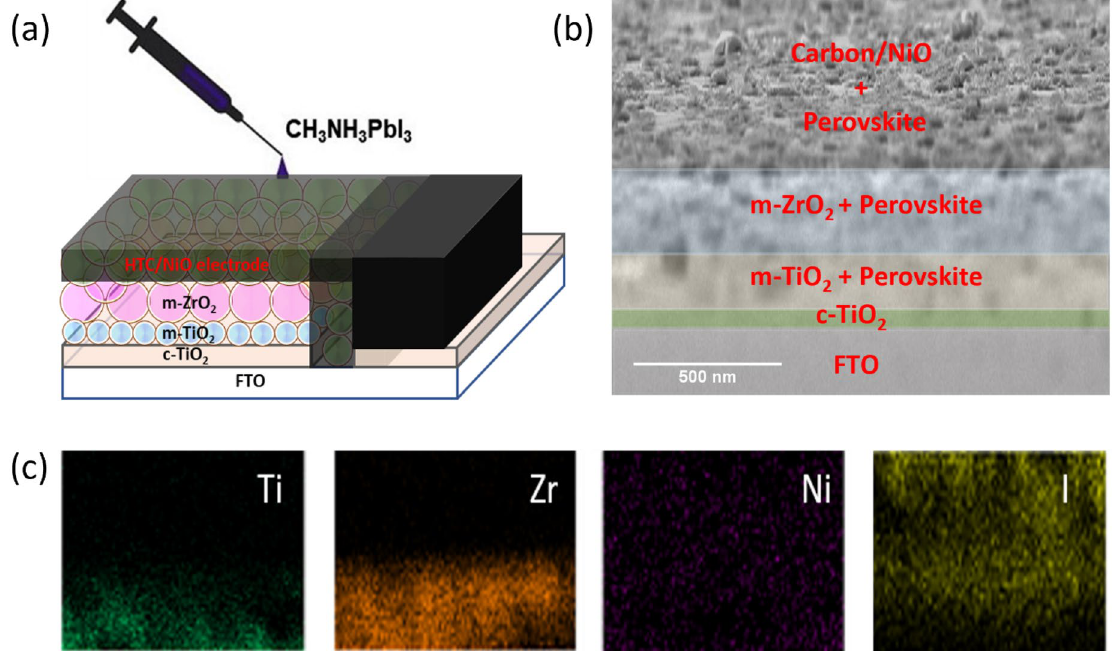
Figure 4. ( a ) Structural representation of HTCN device, ( b ) SEM image of HTCN device showing different layers, ( c ) EDX elemental analysis of Ti, Zr, Ni, I for the HTCN based